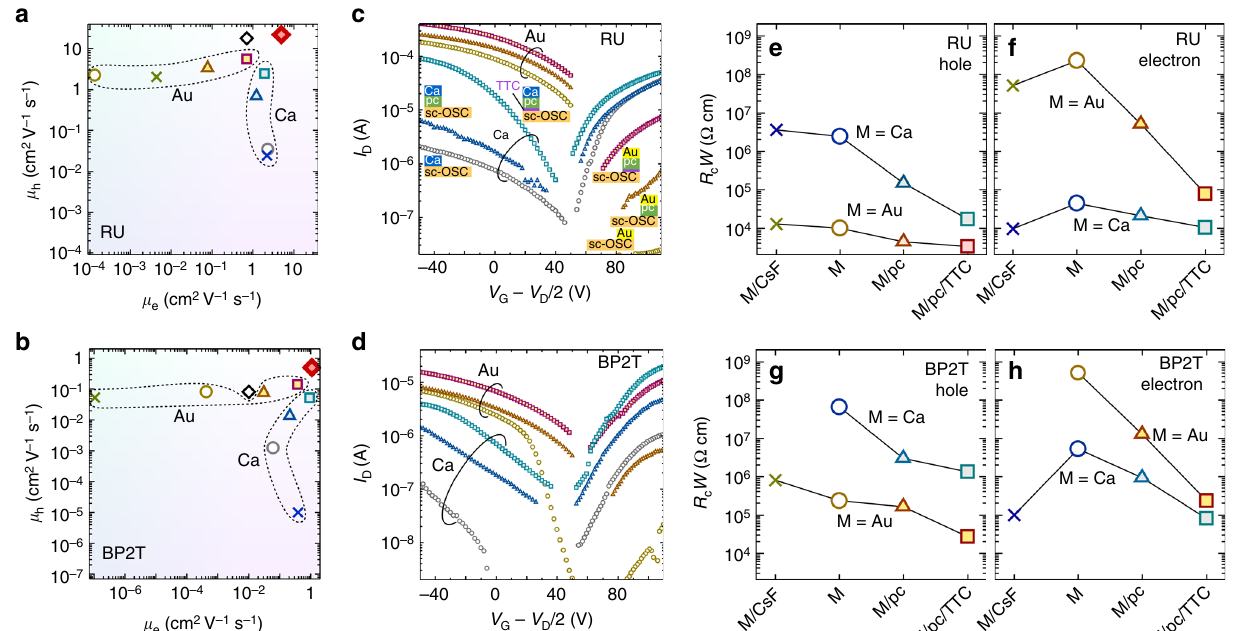
Fig. 3 Transistor characteristics and contact resistances of single-crystalline organic semiconductors. Two-terminal fi eld-effect mobilities of a rubrene (RU) and b BP2T single-crystal OFETs with various electrodes. Yellow-to-magenta marks indicate Au electrodes, and gray and blue-to-cyan marks indicate Ca electrodes: Open circles, closed triangles, closed squares, and crosses indicate no interlayer, pc-OSC interlayer, pc-OSC/TTC interlayer, and CsF interlayer, respectively. Red closed diamonds represent the highest mobilities obtained for FETs employing Au/pc-OSC/TTC and Ca/pc-OSC/TTC asymmetric electrodes (the present work). Open diamonds represent the highest mobilities of BP2T 6, 21 and rubrene 25, 26 single-crystal FETs reported in literature so far. Transfer characteristics of c RU and d BP2T OFETs respectively with various electrodes. Contact resistances of the source electrodes ( R c ) normalized by the channel width ( W ) of various electrodes for e , f RU and g , h BP2T for hole and electron injection